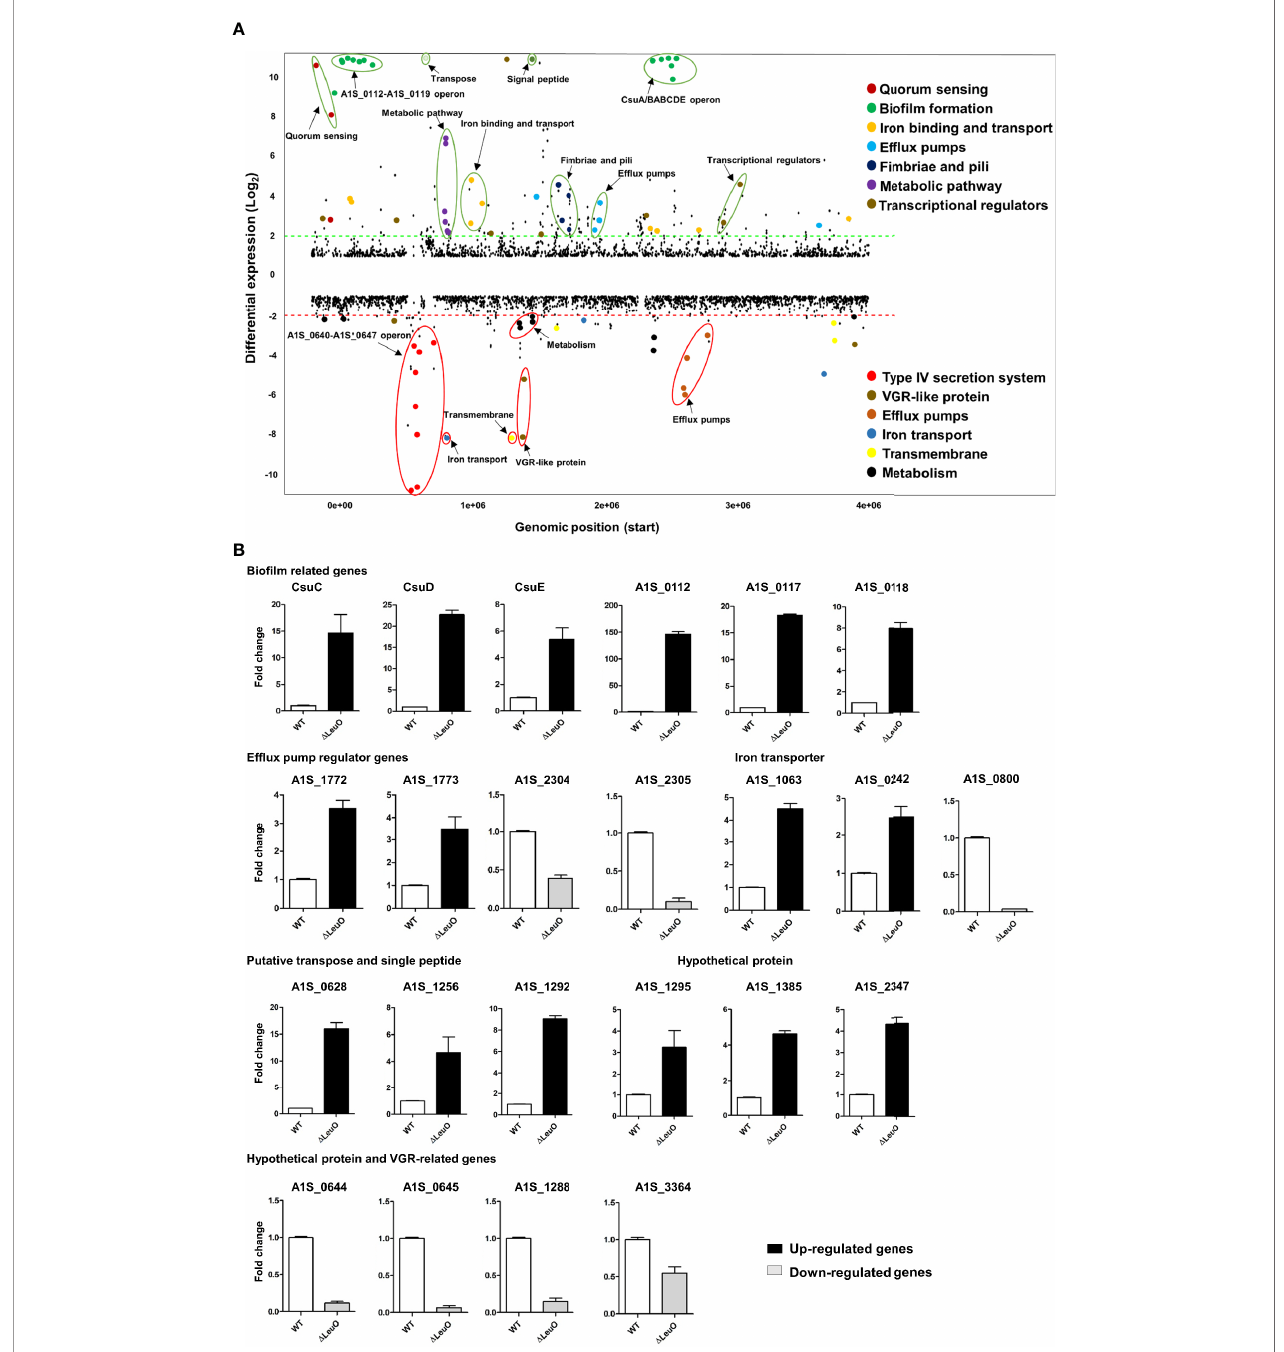
FIGURE 2 | Overview of transcriptional differences between D LeuO and ATCC 17978 wild-type A . baumannii strains and qRT-PCR validation. (A) Comparative transcriptomics of A. baumannii ATCC 17978 and D LeuO strain are displayed as the differential expression. Differential expression levels are presented as fold change (mutant/wild-type) in the Y-axis, and more than 10-fold expression levels are presented above the 10-scale. Each dot indicates the differential expression levels of all predicted open reading frames of the ATCC 17978 genome and sorted according to the locus tag on the X-axis. The dash lines indicate 2-fold differential expression; upregulated and downregulated genes are located above the green line and below the red line, respectively. Gene names or functions of various highly differentially expressed genes are indicated as colored dots and circles and grouped according to functions on the right side. (B) qRT-PCR analysis of selected differentially expressed genes categorized as different functional groups such as bio fi lm-related genes, ef fl ux pump regulator genes, iron transporter, putative transpose and signal peptide, hypothetical protein genes and VGR-related genes. Upregulated genes are presented as black-colored bars, and ash-colored bars represent downregulated genes. The data represent mean ± standard deviation from three biological